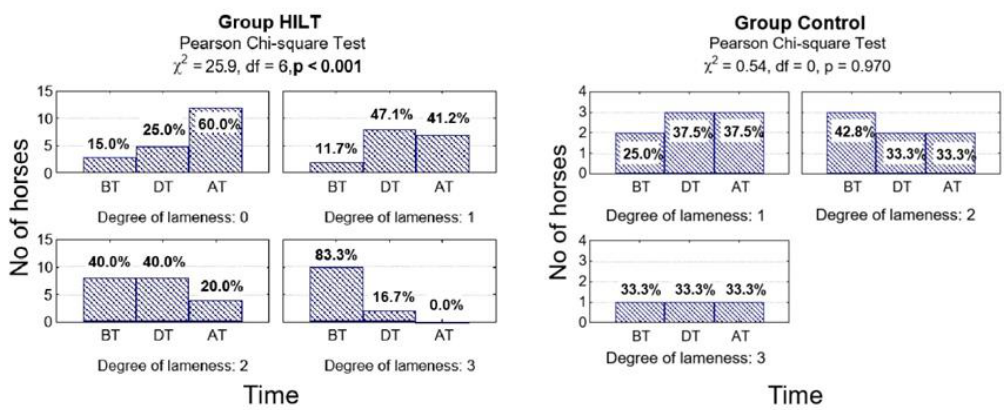
Figure 3. Number (percentage) of horses in groups differing in examination time and degree of lameness on the American Association of Equine Practitioners (AAEP) scale in the HILT group and control group, and the results of the independence test. BT, before treatment (day 0); DT, during treatment (day 13 – 15); AT, after treatment (day 38 – 40).